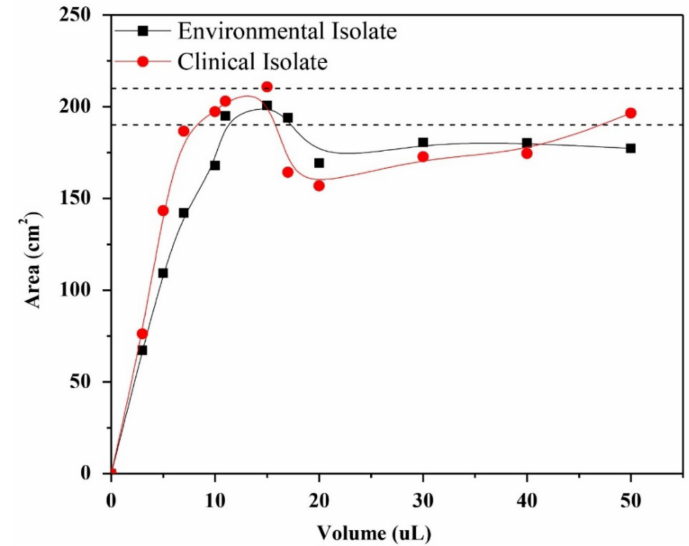
Figure 2. Effect of the volume of the lipid extracts associated to the external surface of the cell wall of the mycelial phase of H. capsulatum of the environmental and clinical isolates on the Teflon trough of the monolayer formed at a surface pressure of 5 mN/m.